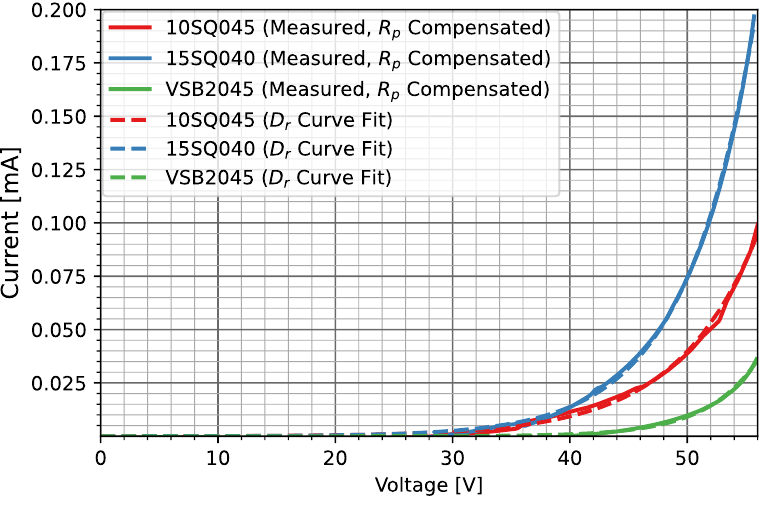
Figure 21. Nonlinear fit of D r for large negative DC voltages for the three